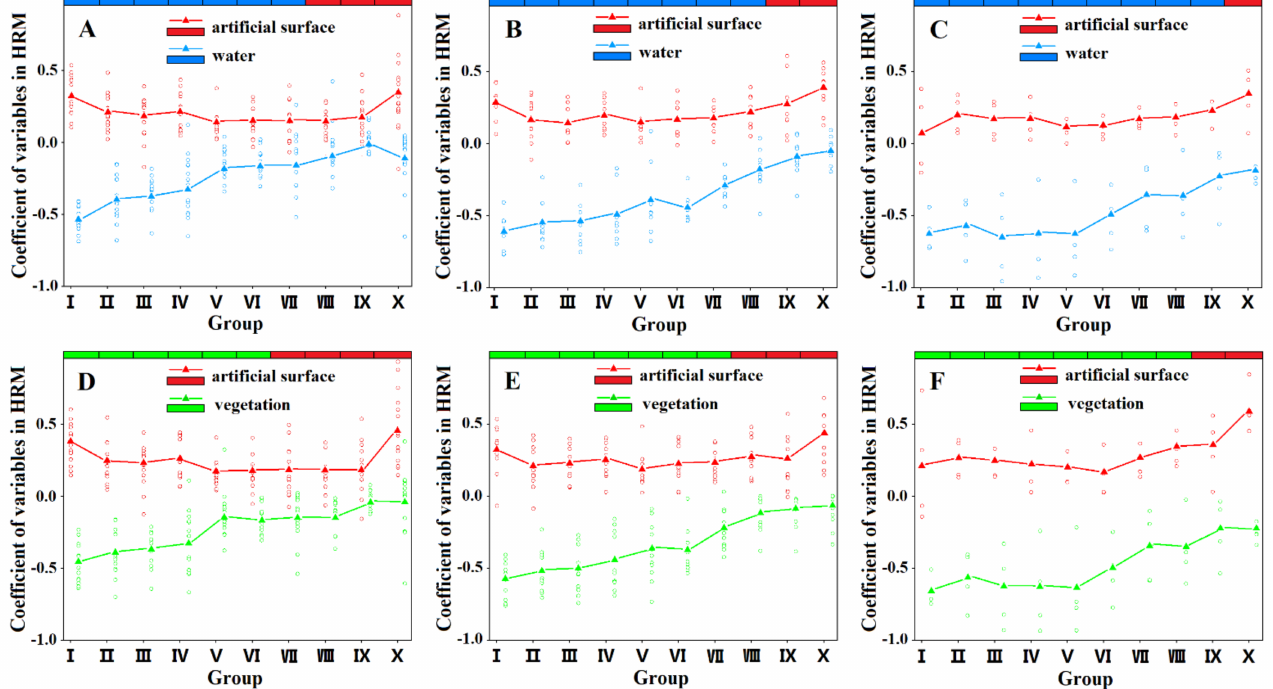
Figure 7. HRM statistics for urban areas within the subtropical zone ( A , D ), temperate and sub- frigid zone ( B , E ), and arid zone ( C , F ), respectively: ( A – C ) the AS–water–LST nexus; ( D – F ): the AS–vegetation–LST nexus.